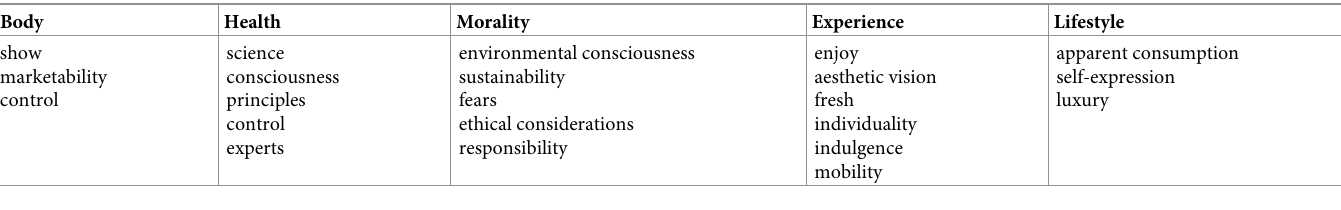
Table 1. Food choice is influenced by the following trend